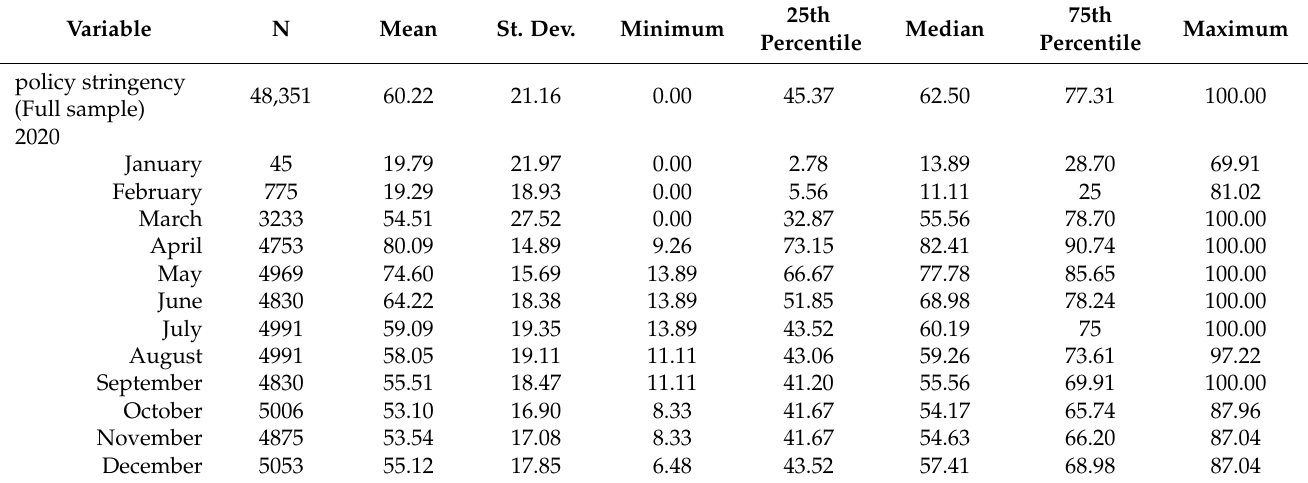
Table 1. Descriptive statistics of the outcome variable.